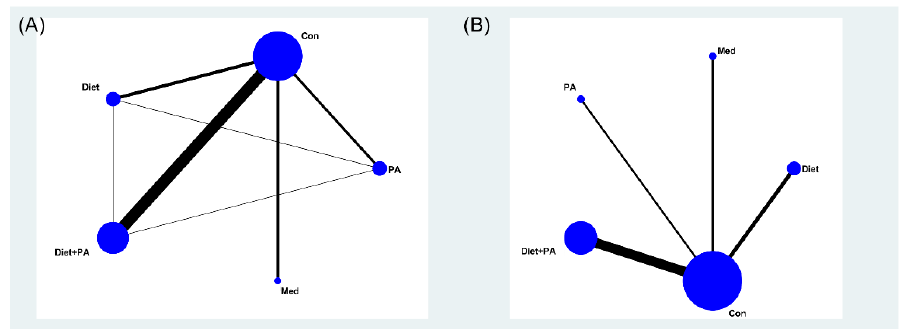
Figure 2. Network meta-analysis maps of the incidence of gestational diabetes mellitus (GDM) ( A ) and gestational weight gain (GWG) ( B ). Abbreviations: physical activity, PA; control, Con; medica- tion, Med.